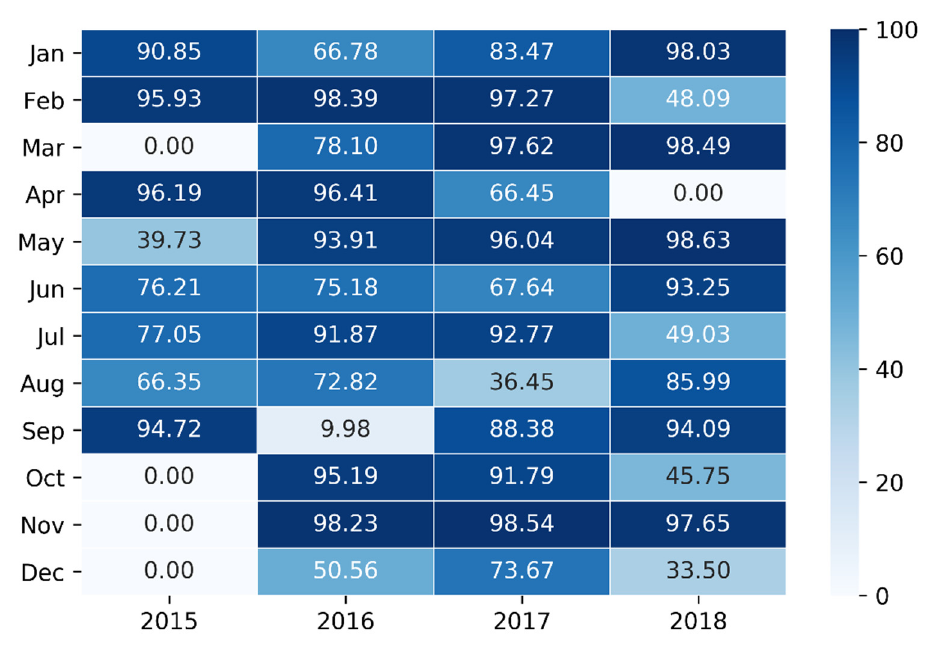
Figure 6. Percentage of scene visibility in Landsat 8 during random forest training time period. S2A and ASTER NDVI (floating point values from 0.0 to 1.0), location (floating point Northing and Easting coordinates of the pixels in meters referenced to UTM Zone 16N, WGS84), and the image acquisition month (encoded as an integer from 1 to 12) were the predictor variables for the virtual constellation model. Including the location as an input feature enables the RF to estimate a value correlated with that of nearby pixels as well as a historically plausible value [54].